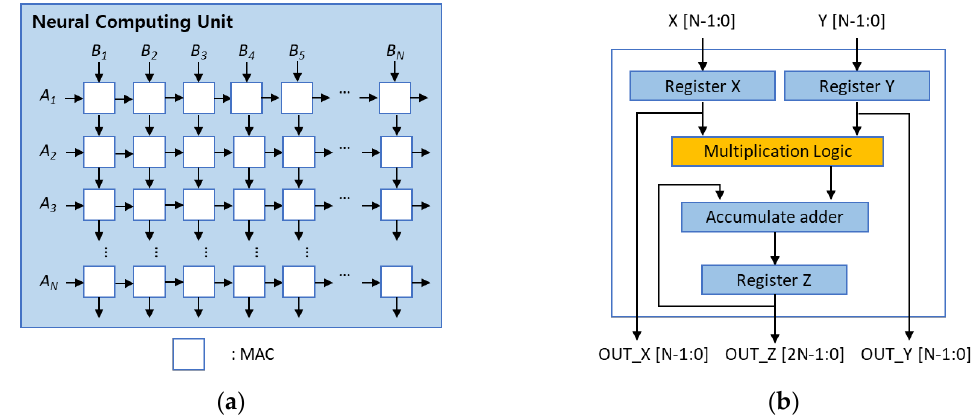
Figure 1. Neural computing unit structure for calculating N × N matrix multiplication: ( a ) Systolic-array neural computing unit; ( b ) Conventional MAC architecture.